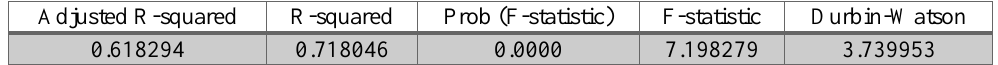
Table 10 . Other results of fixed effects- Model Number